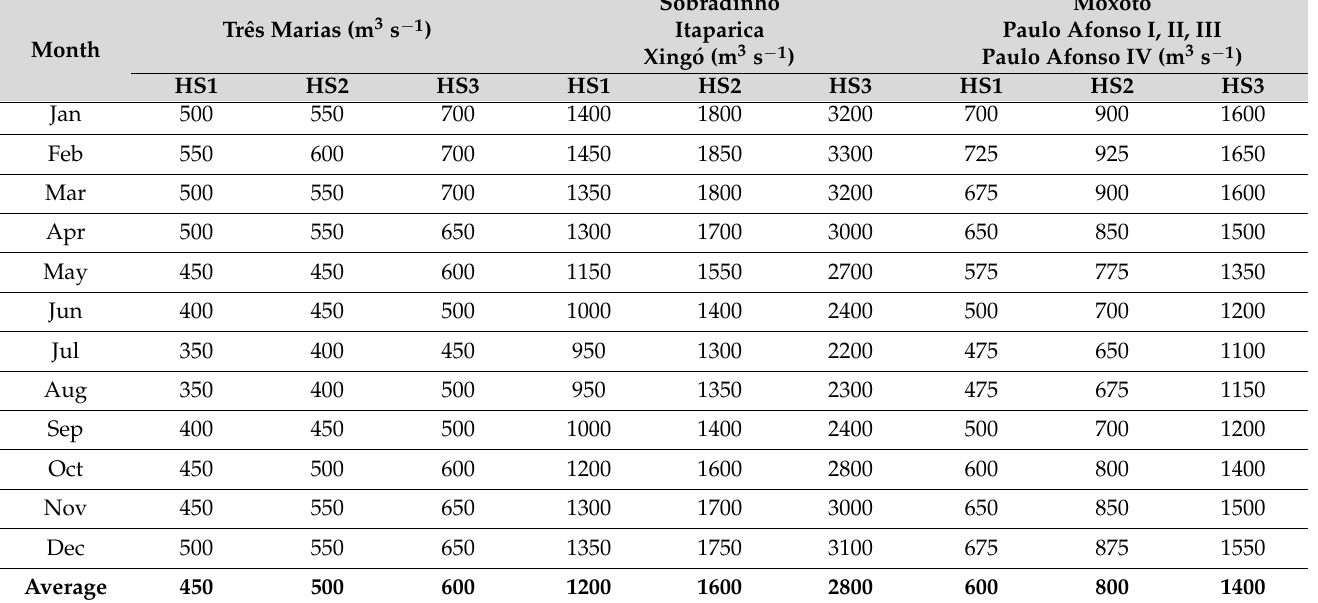
Table 4. Exploitation policy for hydroelectric power plants in the main channel of the S ã o Francisco River (turbocharged flow in m 3 s − 1 ), according with hydrological state